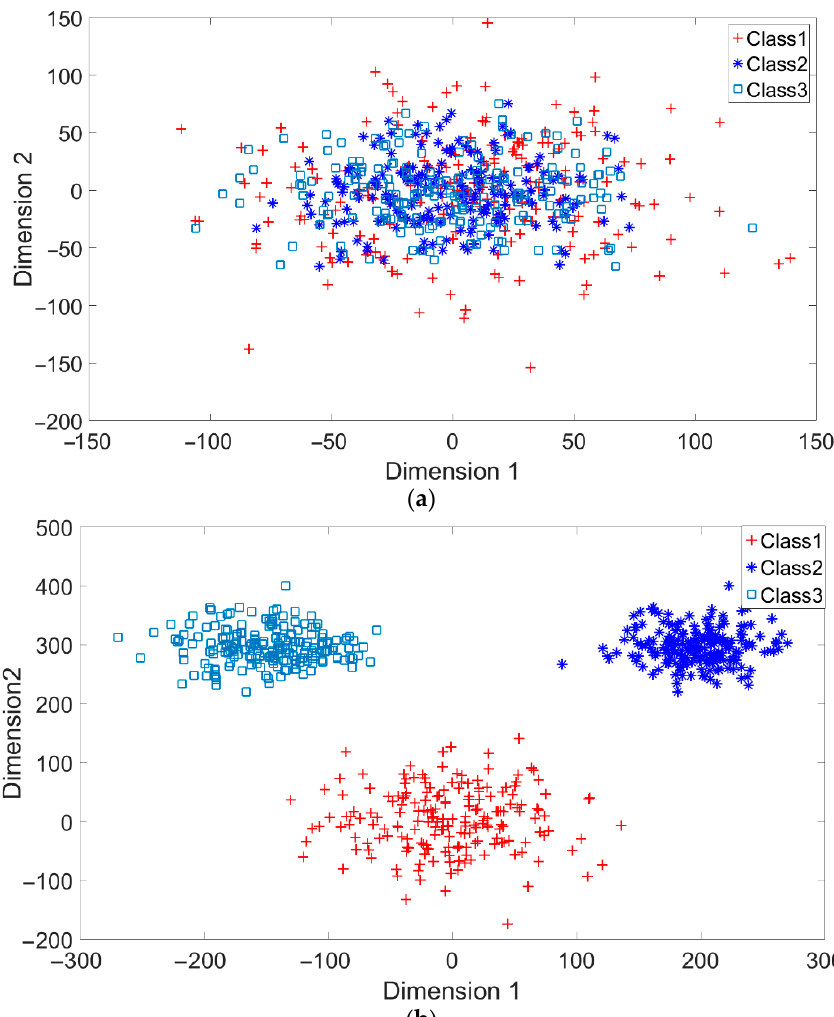
Figure 2. Two toy examples of overlapping: ( a ) High overlapping degree, r = 1, and ( b ) Low overlapping degree, r = 0.24.